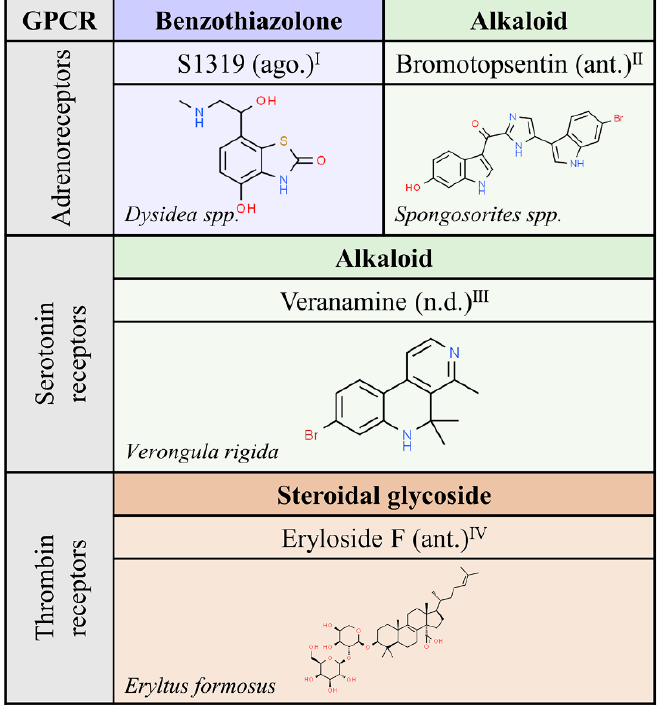
Figure 6. Natural ligands of GPCRs described in non-mammal animals. Each chemical class is highlighted with different colors. The chemical structures were found on ChemSpider website. Ago.: agonist; ant.: antagonist; n.d.: unknown. Superscript: (I) [39]; (II) [40]; (III) [41]; (IV) [42].